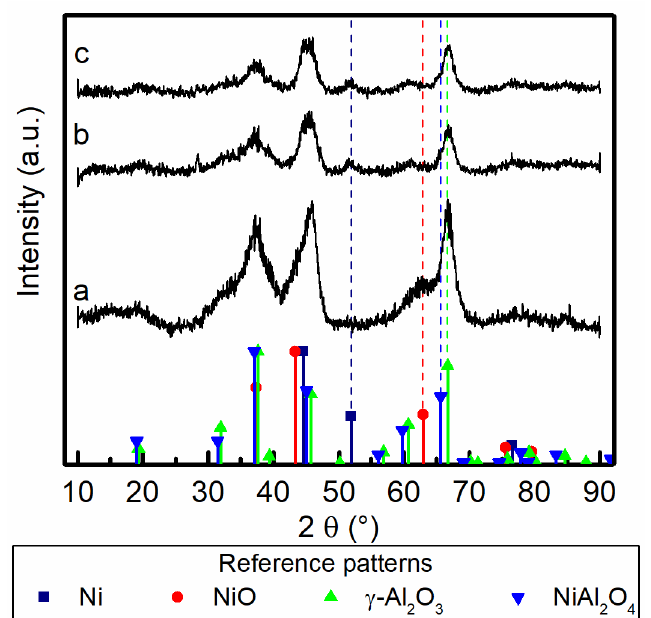
Figure 4. X-ray di ff ractograms of ( a ) fresh activated catalyst, ( b ) aged at 380 ◦ C for 100 h and ( c ) aged Figure 4. X-ray diffractograms of ( a ) fresh activated catalyst, ( b ) aged at 380 °C for 100 h and ( c ) aged 425 ◦ C for 100 h. The di ff ractogram was compared with the reference patterns of Ni (01-087-0712), NiO 425 °C for 100 h. The diffractogram was compared with the reference patterns of Ni (01-087-0712), (01-078-0429), γ -Al 2 O 3 (96-201-5531) and NiAl 2 O 4 (00-010-0339). NiO (01-078-0429), γ -Al 2 O 3 (96-201-5531) and NiAl 2 O 4 (00-010-0339).